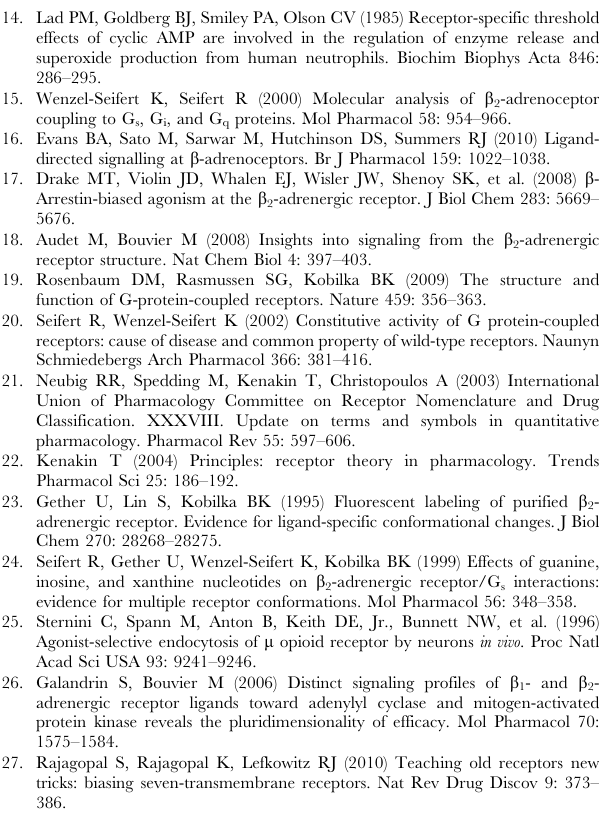
Figure S1 Structures of the b 2 AR agonists and antago- nists examined in this study. Figure S2 Structures of cAMP and cAMP analogs examined in this